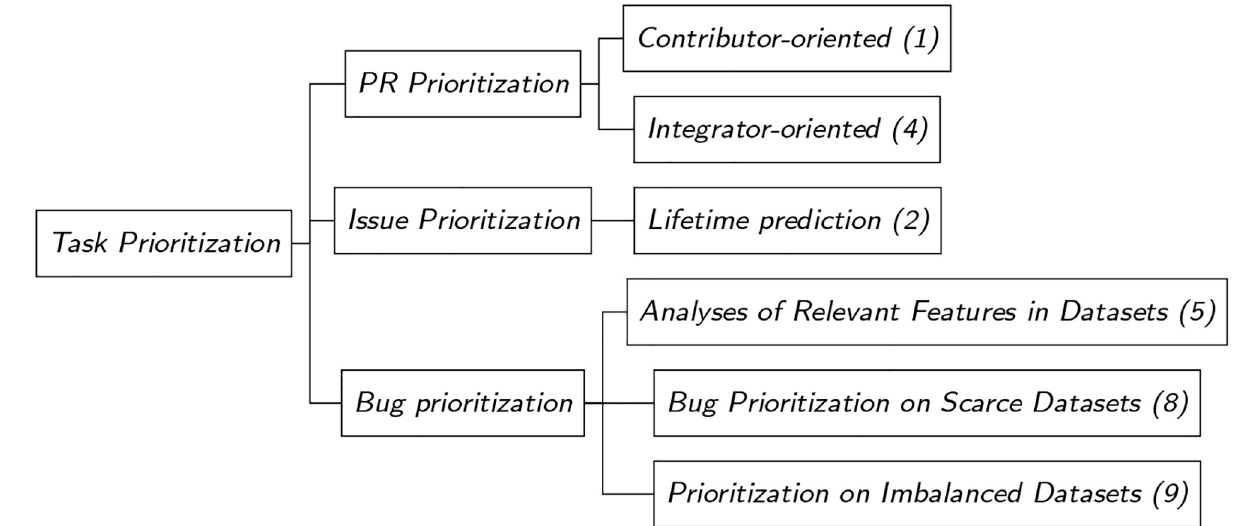
Fig 13. Branches of task prioritization. The numbers in brackets indicate the number of publications found for each branch.